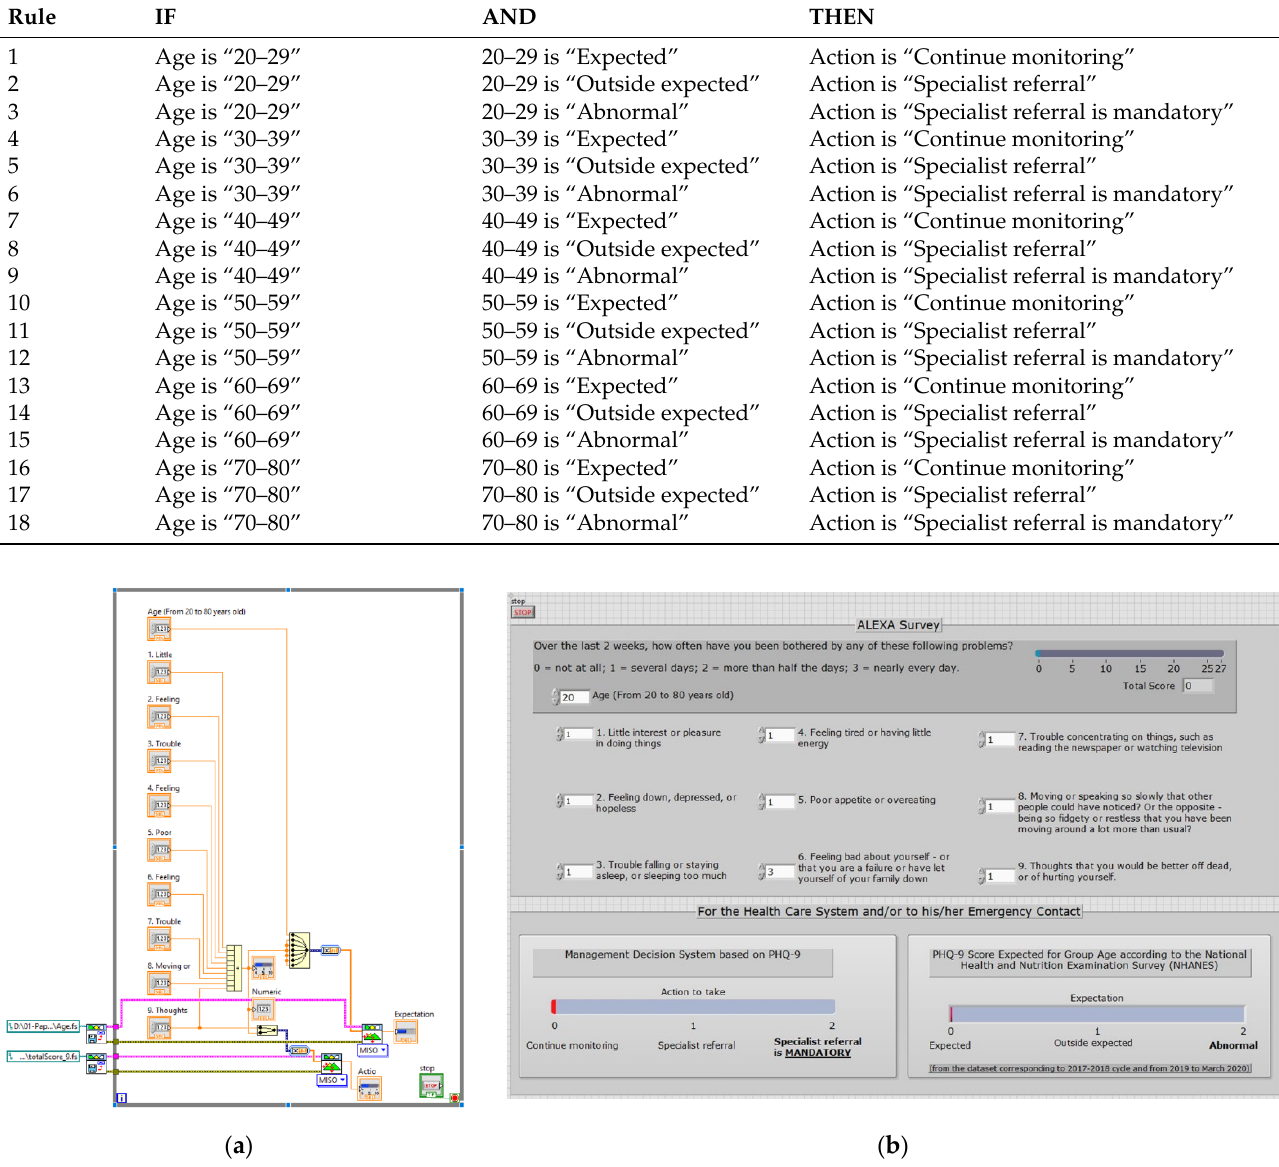
Figure 6. LabView project: ( a ) block diagram; ( b ) front panel.